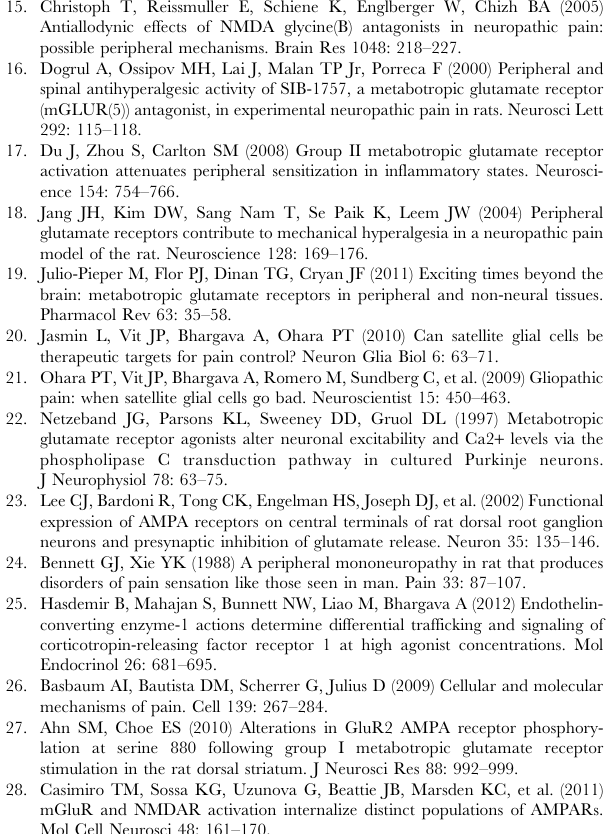
Figure S3 GluA1 expression in small and medium diameter neurons after CCI. Immunofluorescence showed that GluA1 immunoreactivity (GluA1-IR) was largely found in small and medium diameter DRG neurons after CCI (red arrows). In control animals, GluA1-IR was predominantly detected on small diameter neurons (red arrows). After CCI, the proportion of small and medium diameter GluA1-IR positive neurons appeared to increase in three different sections visualized. Scale bar: 50 m